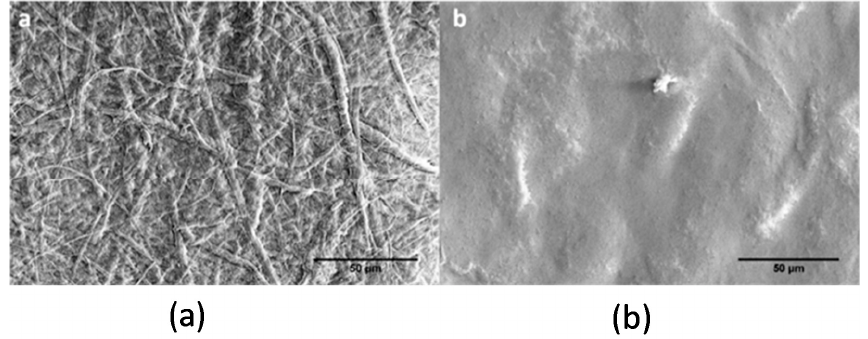
Figure 2. SEM images of the morphology of ( a ) NFC and ( b ) nanocrystalline cellulose (NCC) spin-coated on the Si-wafers.